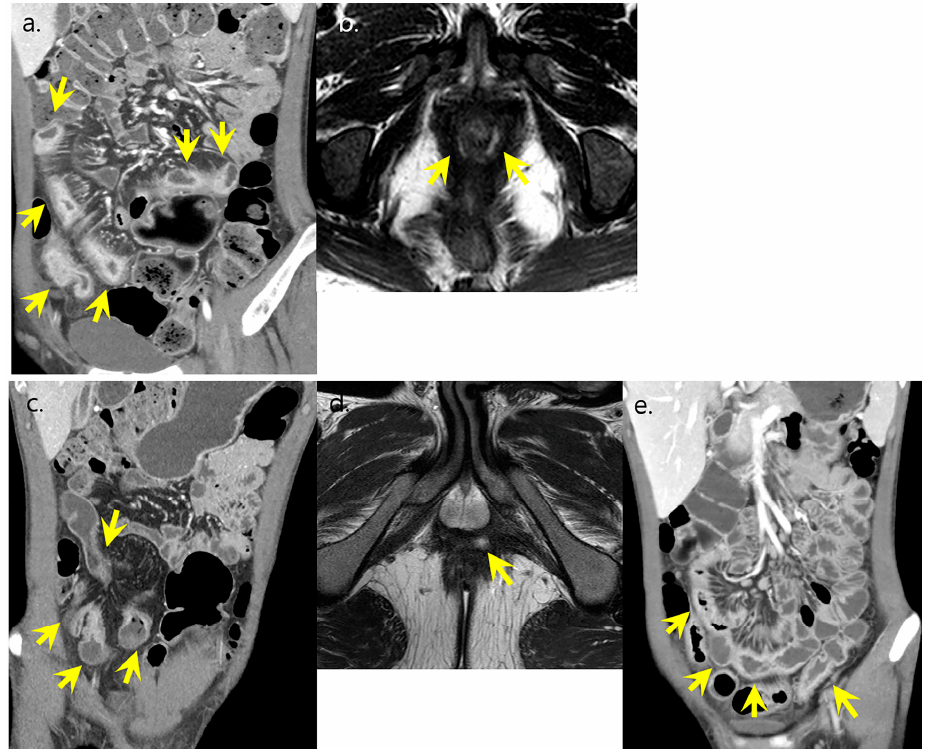
Figure 5. A 22-year-old male with Crohn’s disease showing unfavorable disease course. ( a , b ) Initial CT and MR showed severe active inflammation in entire ileum and ileocolon with active perianal lesion. (arrows) CT scores were graded as severe activity. ( c , d ) Follow-up exams after 2 years showed persisting active bowel inflammation and perianal lesion. (arrows) ( e ) CT activity was graded as severe due to persistent active bowel inflammation at the last follow up